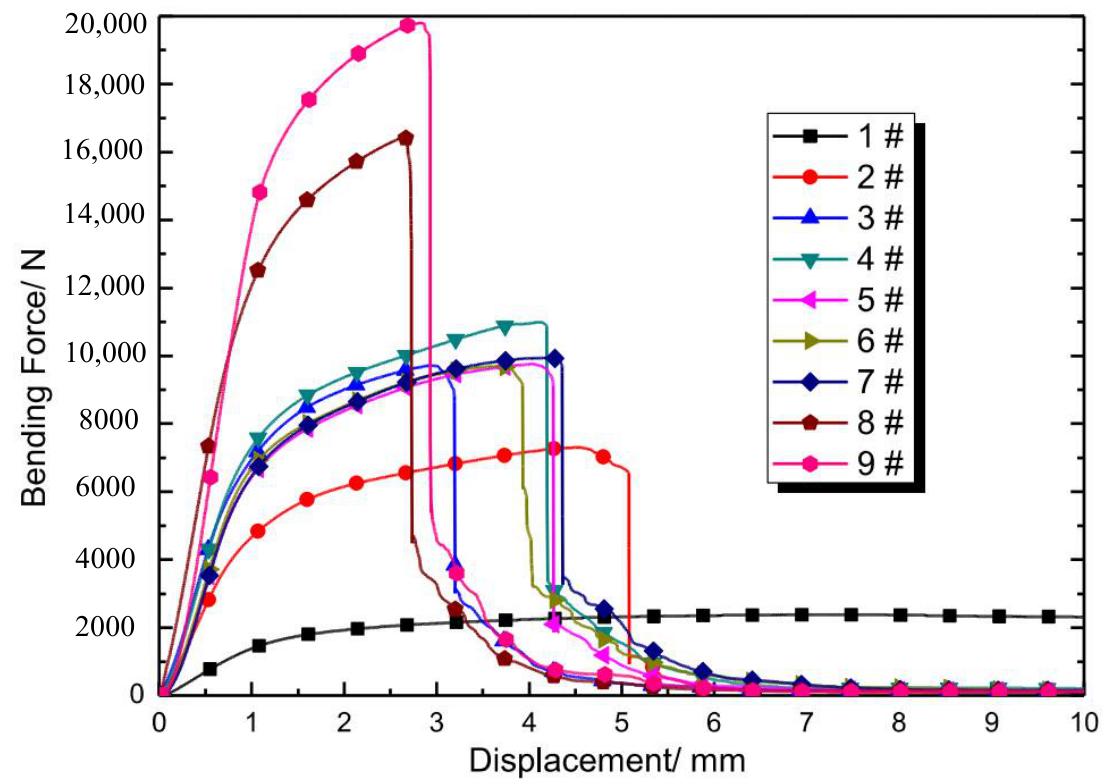
Figure 7. Bending force-displacement curves of specimens with different geometric parameters. The structural features of each coded sample are indicated in Table 1.